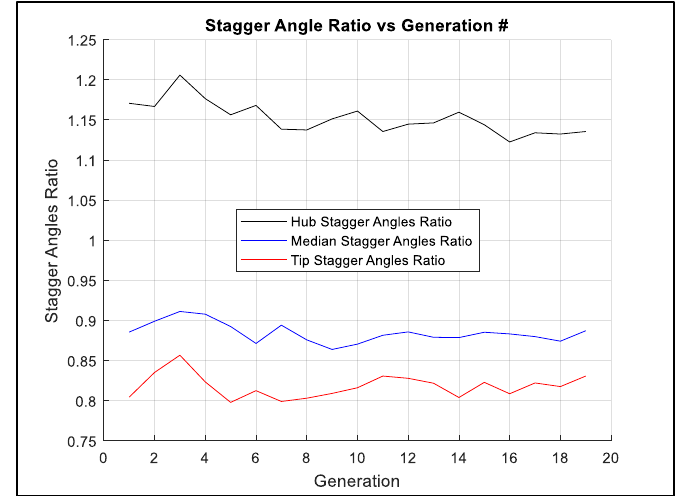
Figure 20. Elite member stagger angles ratio against generation number.